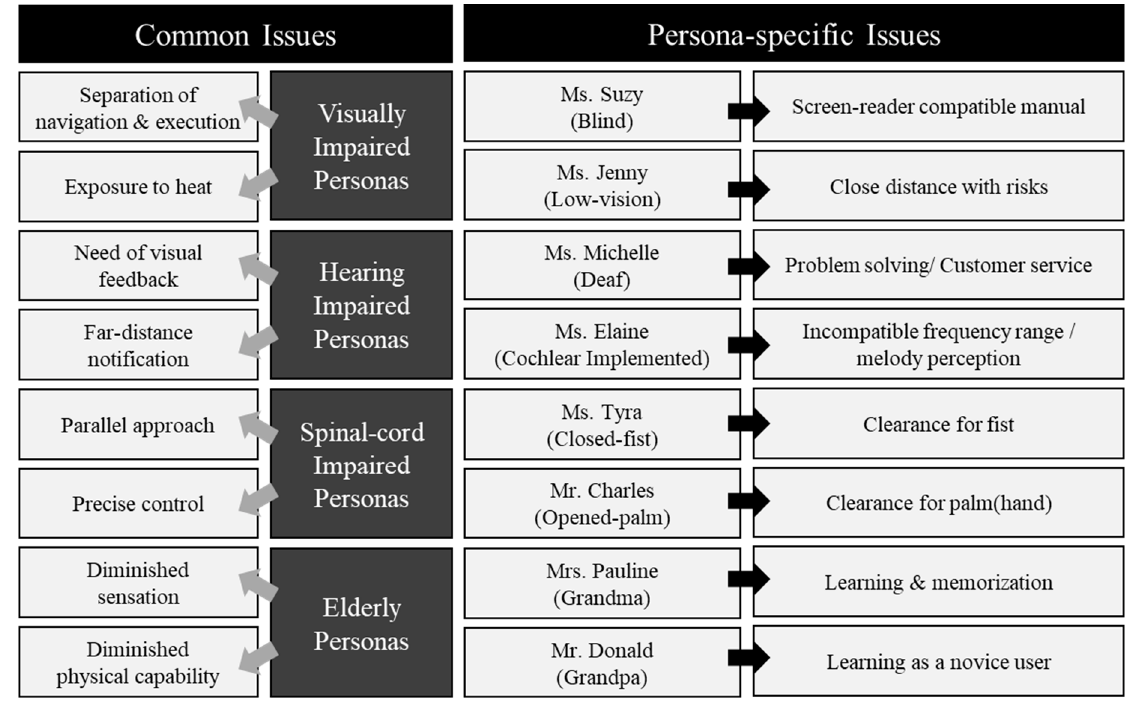
Figure 6. Accessibility issues of Personas-common and persona-specific.